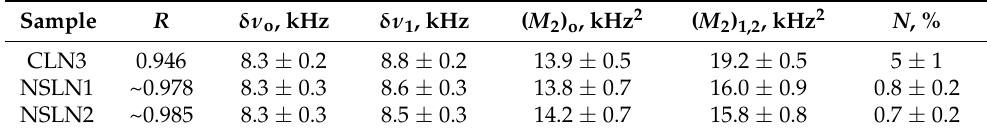
Figure 8. First derivative of 7 Li NMR spectrum in the CLN3 and NSLN2 samples at θ = 0°. *3 — the weak side lines of CLN3 magnified 3 times, *16—the weak side lines of NSLN2 magnified 16 times. Table 4. Line parameters of the 7 Li NMR spectrum of three LN crystals at θ = 0°.